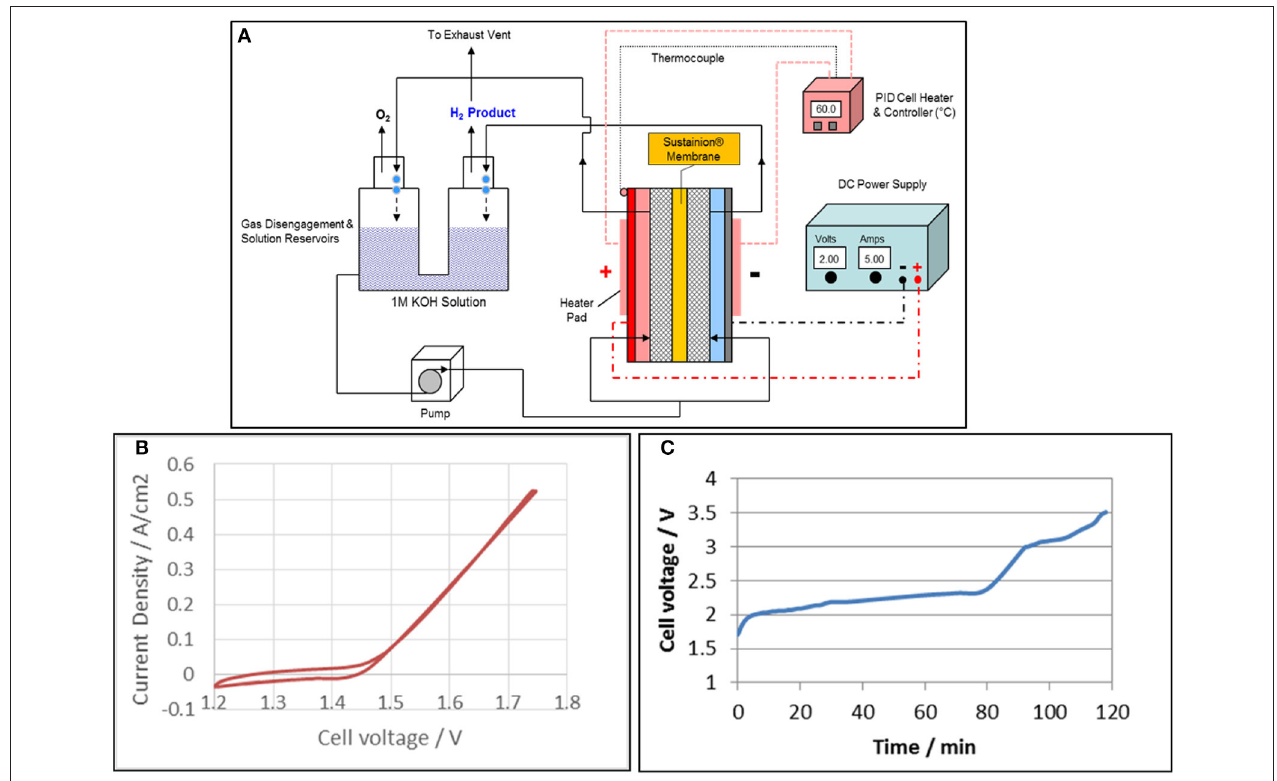
FIGURE 10 | Alkaline water electrolysis experimental test system for 5 cm 2 test cells is shown in (A) . A typical cyclic voltammogram of the alkaline water electrolyzer with a Sustainion ® anion exchange membrane based on functionalization with 1-methyl imidazole is shown in (B) and the corresponding cyclic voltammogram is shown in (C) . A Pt cathode and IrO 2 anode were used and the cell was operated in 1M KOH at 60 ◦